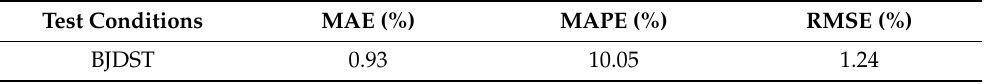
Table 4. Model evaluation index in a variable temperature environment. Figure 10. Estimated results of BJDST in a variable temperature environment: estimated results ( a ) and estimated errors ( b ).